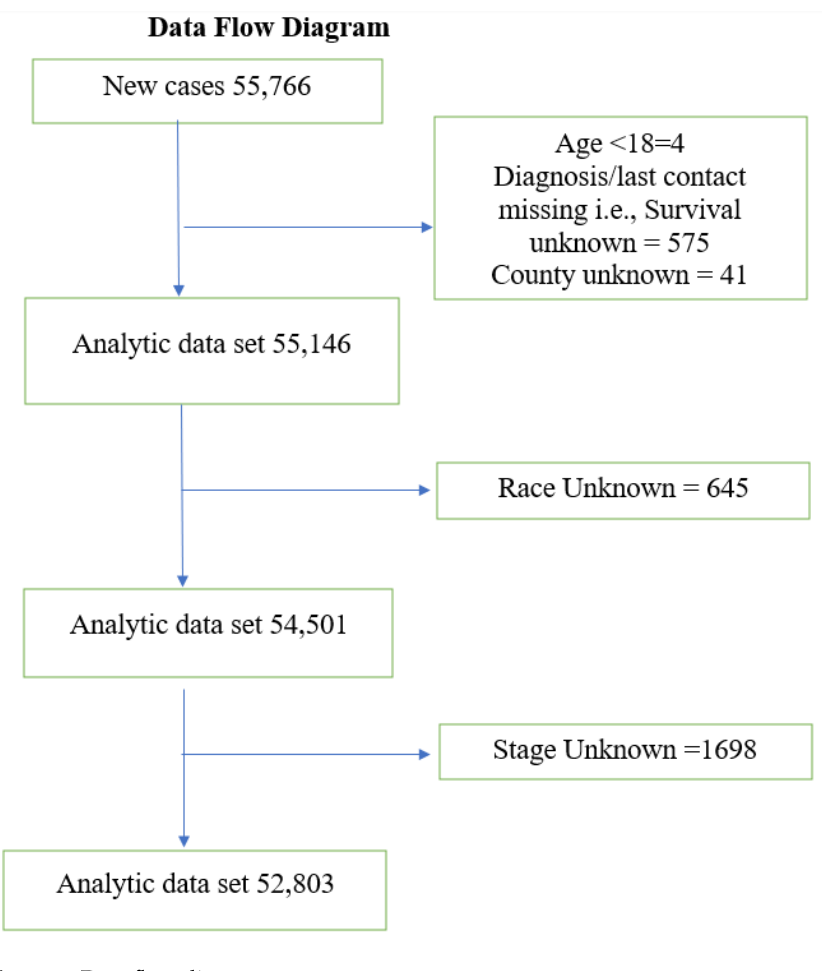
Figure 1. Date flow diagram.